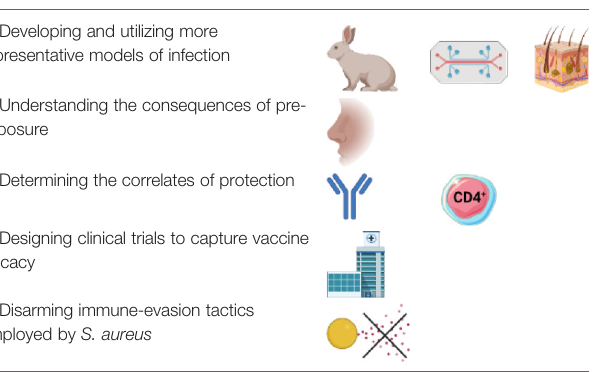
TABLE 3 | Future directions of Staphylococcus aureus vaccinology